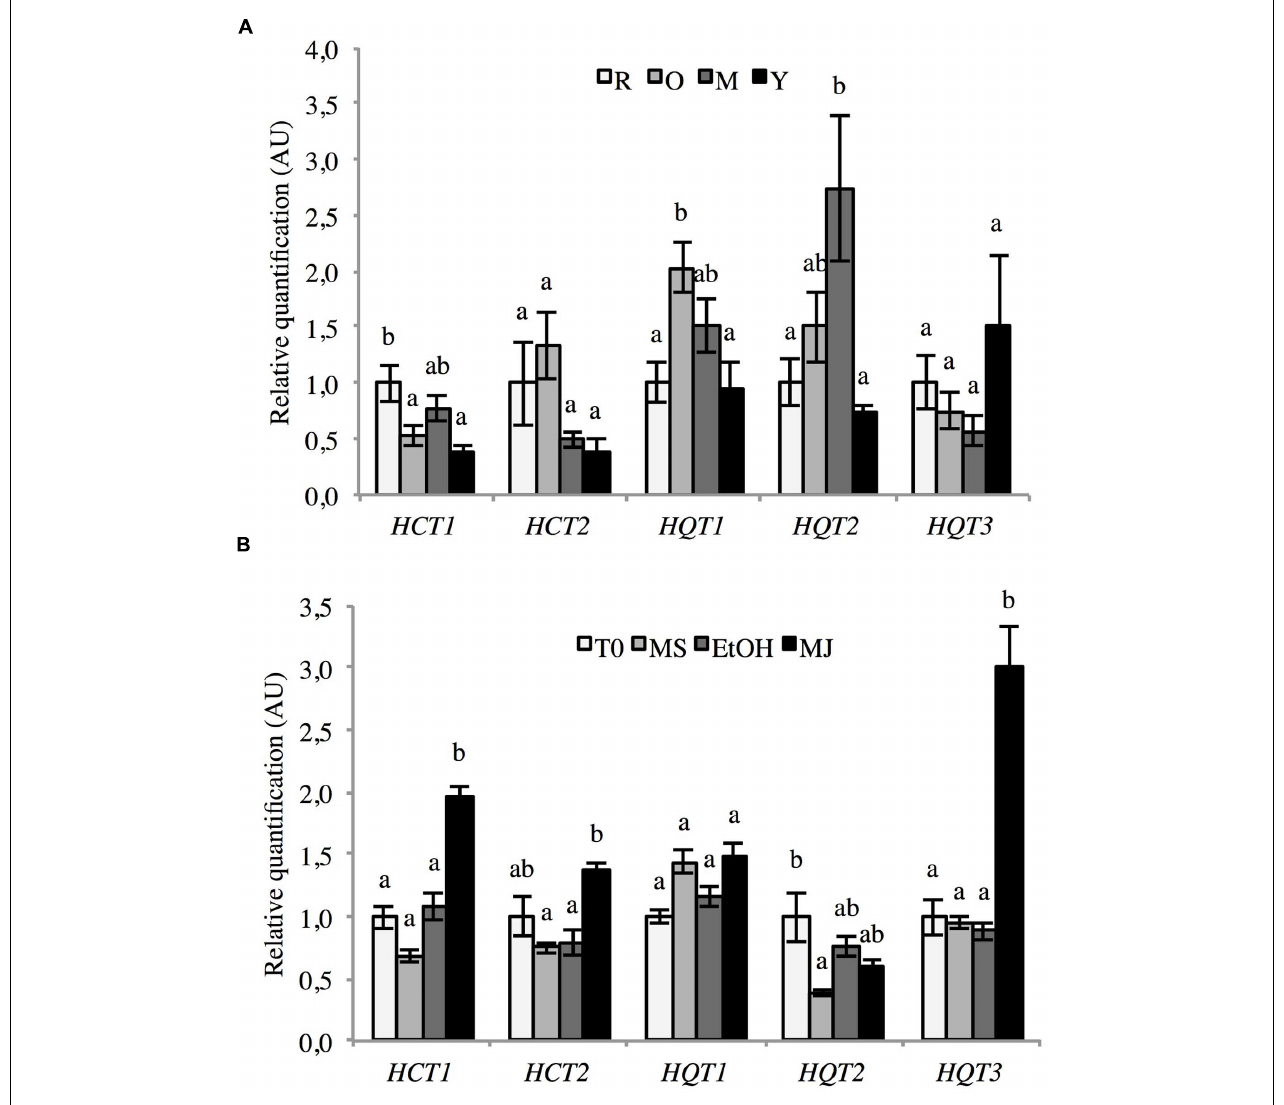
FIGURE 8 | Expression of HCT1, HCT2, HQT1, HQT2, and HQT3 in various chicory tissues. mRNA abundance in different parts of 6-weeks-old seedlings (A) and culture cells elicited or not with MeJA (B) was determined by qRT-PCR. (A) Expression levels were normalized to the expression of CLATH and SAND and presented relative to that of Roots. Y: young leaves, M: intermediate leaves, O: Old leaves, R: roots. (B) Expression levels were normalized to the expression of TIP41 and PP2AA2 and presented relative to that of T0. T0: cells sampled before elicitation, MS: cultures kept on MS medium for 24 h, EtOH: cell cultures treated with ethanol for 24 h, MJ: cell cultures treated with 50 µ M MeJA for 24 h. Error bars indicate SEM. Different letters above histograms indicate statistical difference highlighted using ANOVA ( P -value <